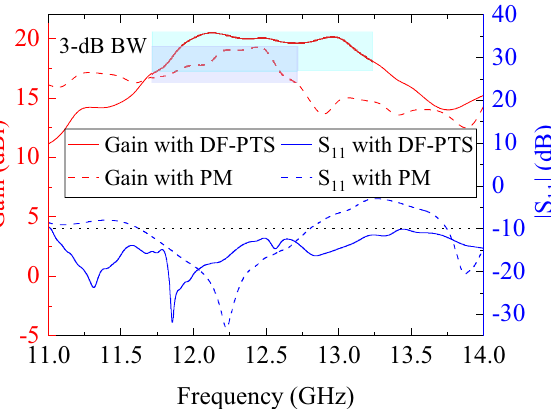
Figure 7. Comparison of input reflection magnitudes and peak gains of RCAs that are phase-corrected using DF-PTS and PM.